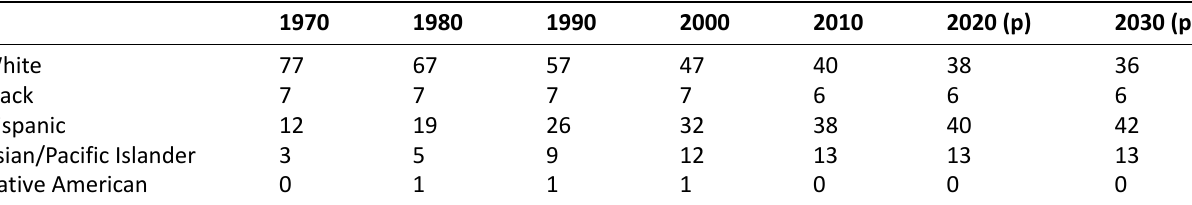
Table 2. Changing California Demographics (%). Source: California Department of Finance. California’s population has be- come far more diverse since 1970, with the trend projected to continue through at least 2030.